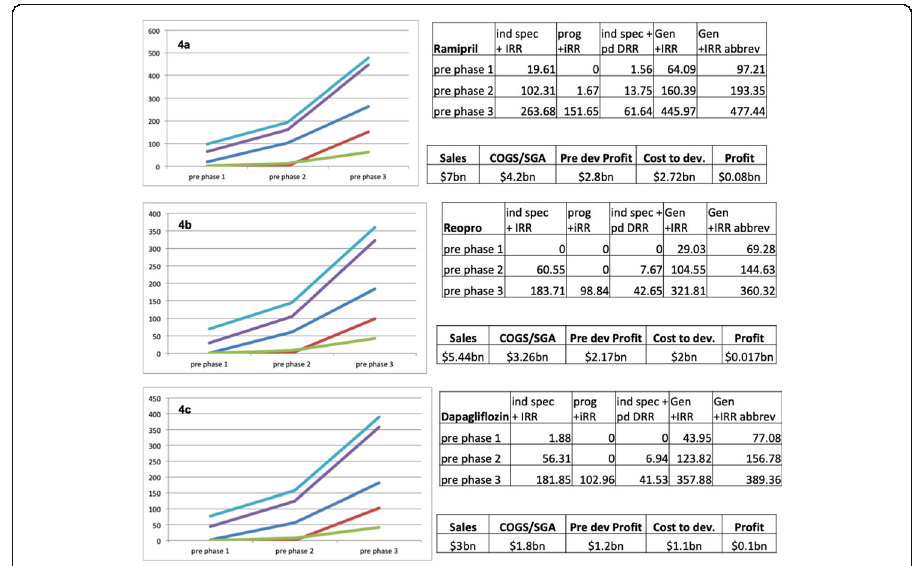
Fig. 4 Comparison of rNPV models used in study when applied to real world revenue generating medical interventions. F or three large revenue-generating medical interventions, rNPV modelling was performed using the 5 major simulation models of this study. Ramipril/Tritace ( a ), Reopro ( b ), and dapagliflozin( c ) were used as examples, with real numbers indicated in the tables corresponding to rNPV values, as well as sales, COGS, pre-development profit, estimated cost to develop, and profit